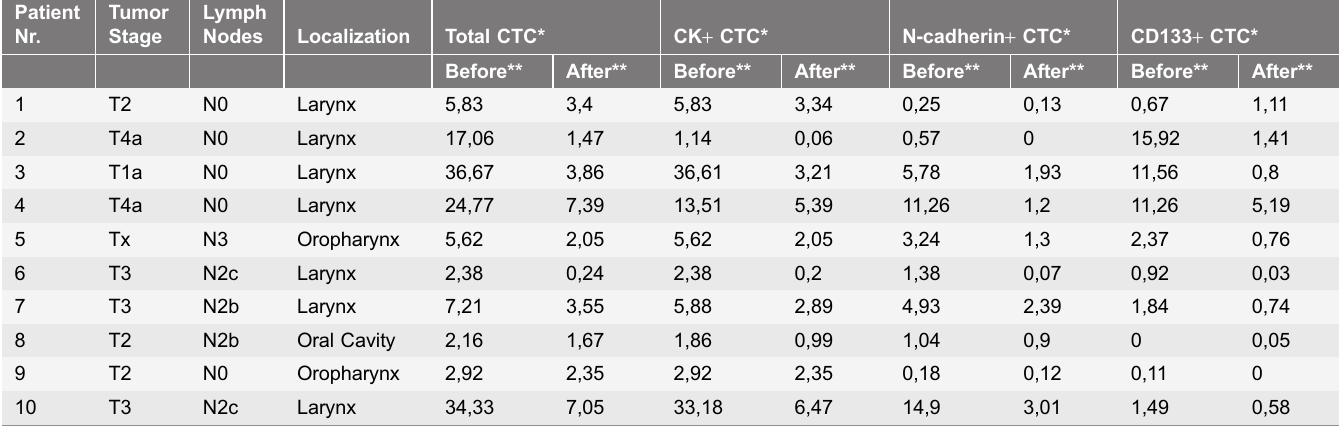
Table 4. Clinical Data and CTC Subtypes. Patient